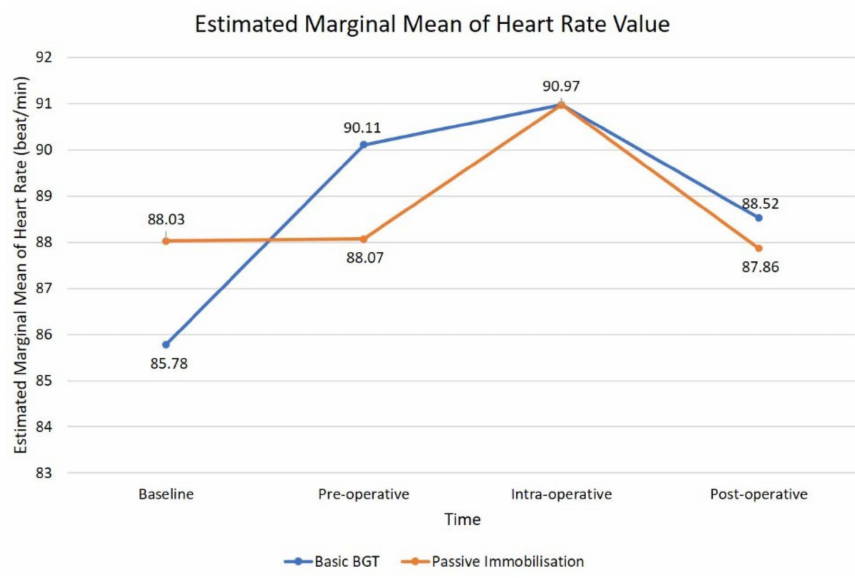
Figure 4. Graph pattern of cumulative means values of heart rate at four time periods.